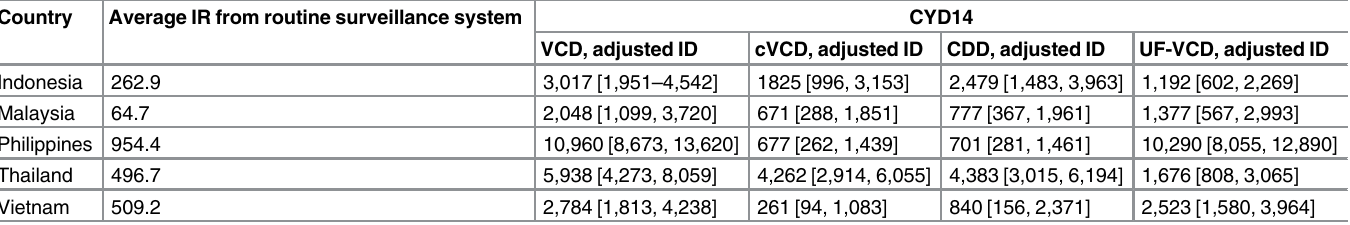
Incidence rates and densities are in cases/100,000 person-years. Incidence rates for routine surveillance calculated from total number of cases over the period of study and study mid-point populations. IR, incidence rate; VCD, virologically con fi rmed dengue; ID, incidence density; CI, con fi dence interval; cVCD, clinically diagnosed and virologically con fi rmed dengue; CDD, clinically diagnosed dengue; UF-VCD, virologically con fi rmed dengue not diagnosed as dengue.